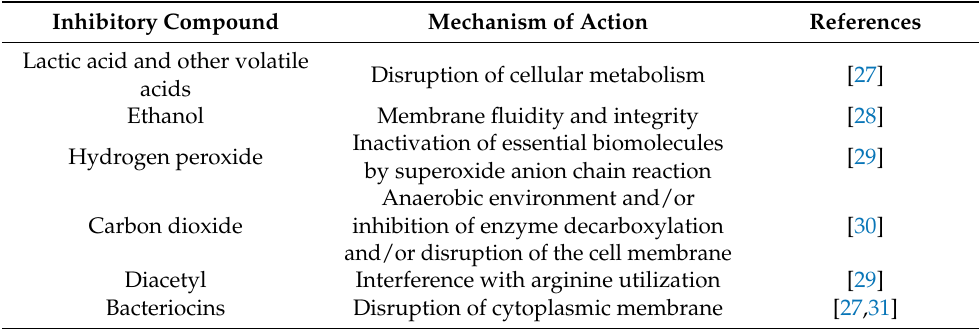
Table 2. Inhibitory compounds produced by selected LABs and their mechanisms of action against pathogens microorganisms, such as L. monocytogenes